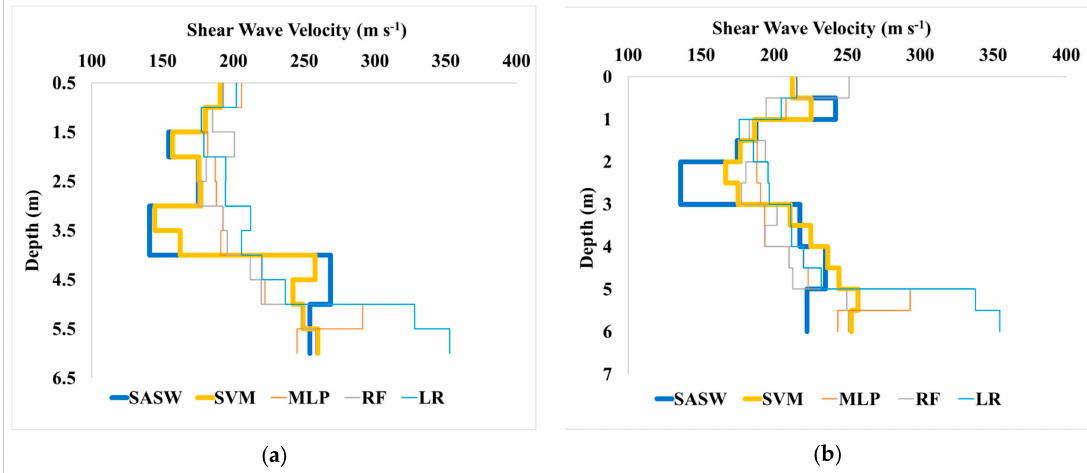
Figure 14. V S profiles from SASW inversion and ML algorithms for ( a ) test 3 and ( b ) test 4. SVR showed notable results up to 6 m for Figure 15a,b and Figure 16a,b as well. The values obtained from the SVR deflected at the first layer for tests 5 and